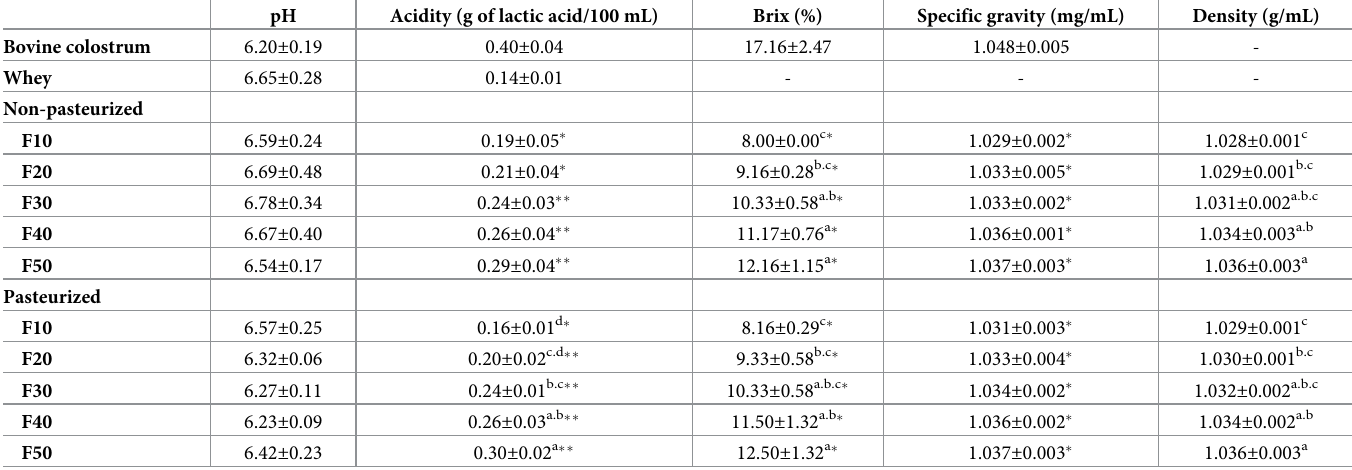
Table 2. Physicochemical and quality characteristics of the formulations according to the addition of bovine colostrum and comparison with the physicochemical characteristics of bovine colostrum and whey. pH Acidity (g of lactic acid/100 mL) Brix (%) Specific gravity (mg/mL) Density